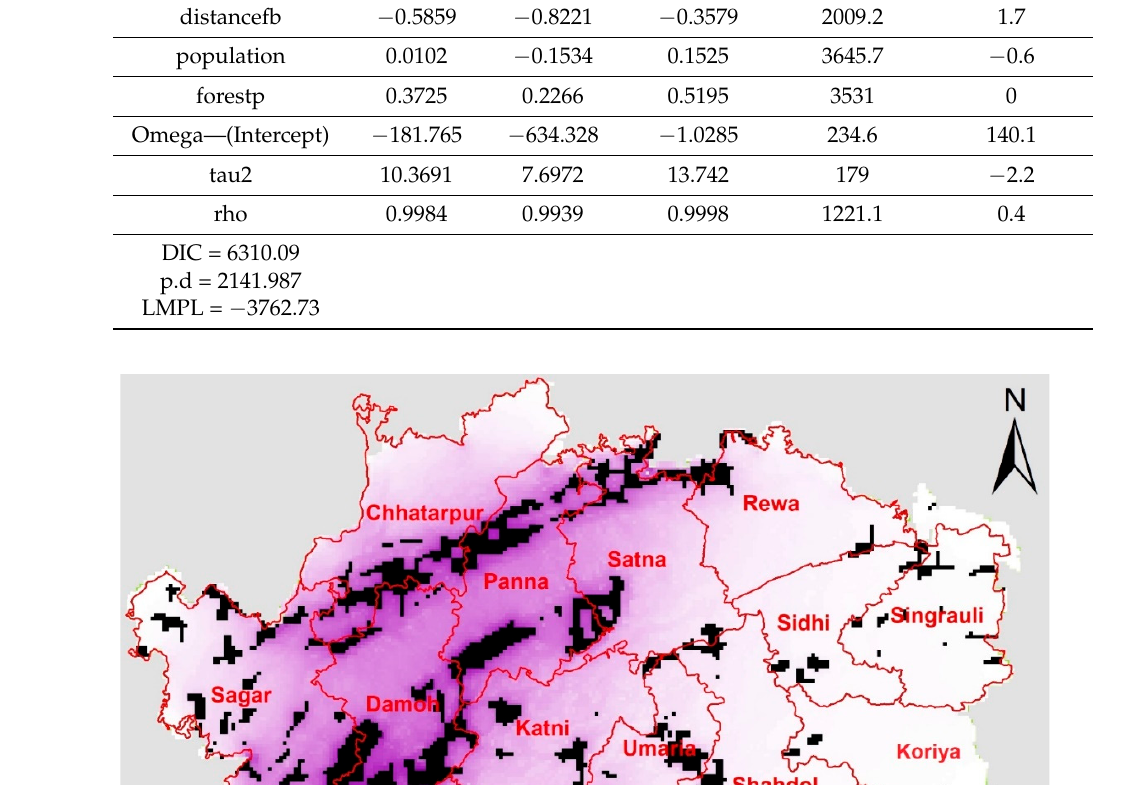
Table A2. Posterior quantities and DIC of the CARBayes analysis.